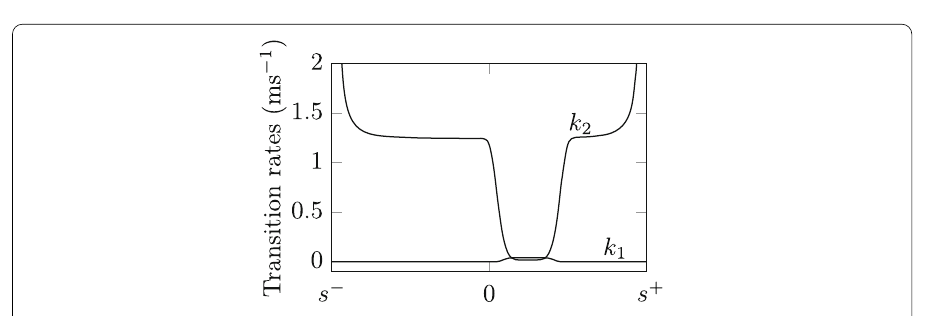
Fig. 7 Transition rates parametrization for the Huxley’57 model